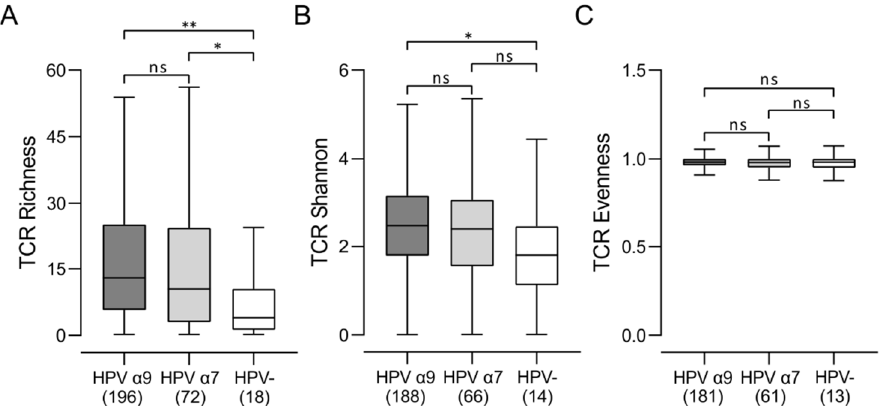
Figure 8. Comparison of the T-cell receptor (TCR) repertoire between HPV-positive (HPV α 9 and HPV α 7) and HPV-negative (HPV-) cervical cancers. ( A ) Comparison of unique TCR sequences in the TCR repertoire (richness); ( B ) comparison of clonal diversity weighted by the abundance of each complementarity-determining region 3 (Shannon entropy); ( C ) comparison of the distribution spectrum of TCR sequences, reflecting the relative abundance of individual T-cell clones (evenness). Numbers in brackets refer to the number of samples included in each analysis. ** p ≤ 0.01, * p ≤ 0.05, ns (not significant).